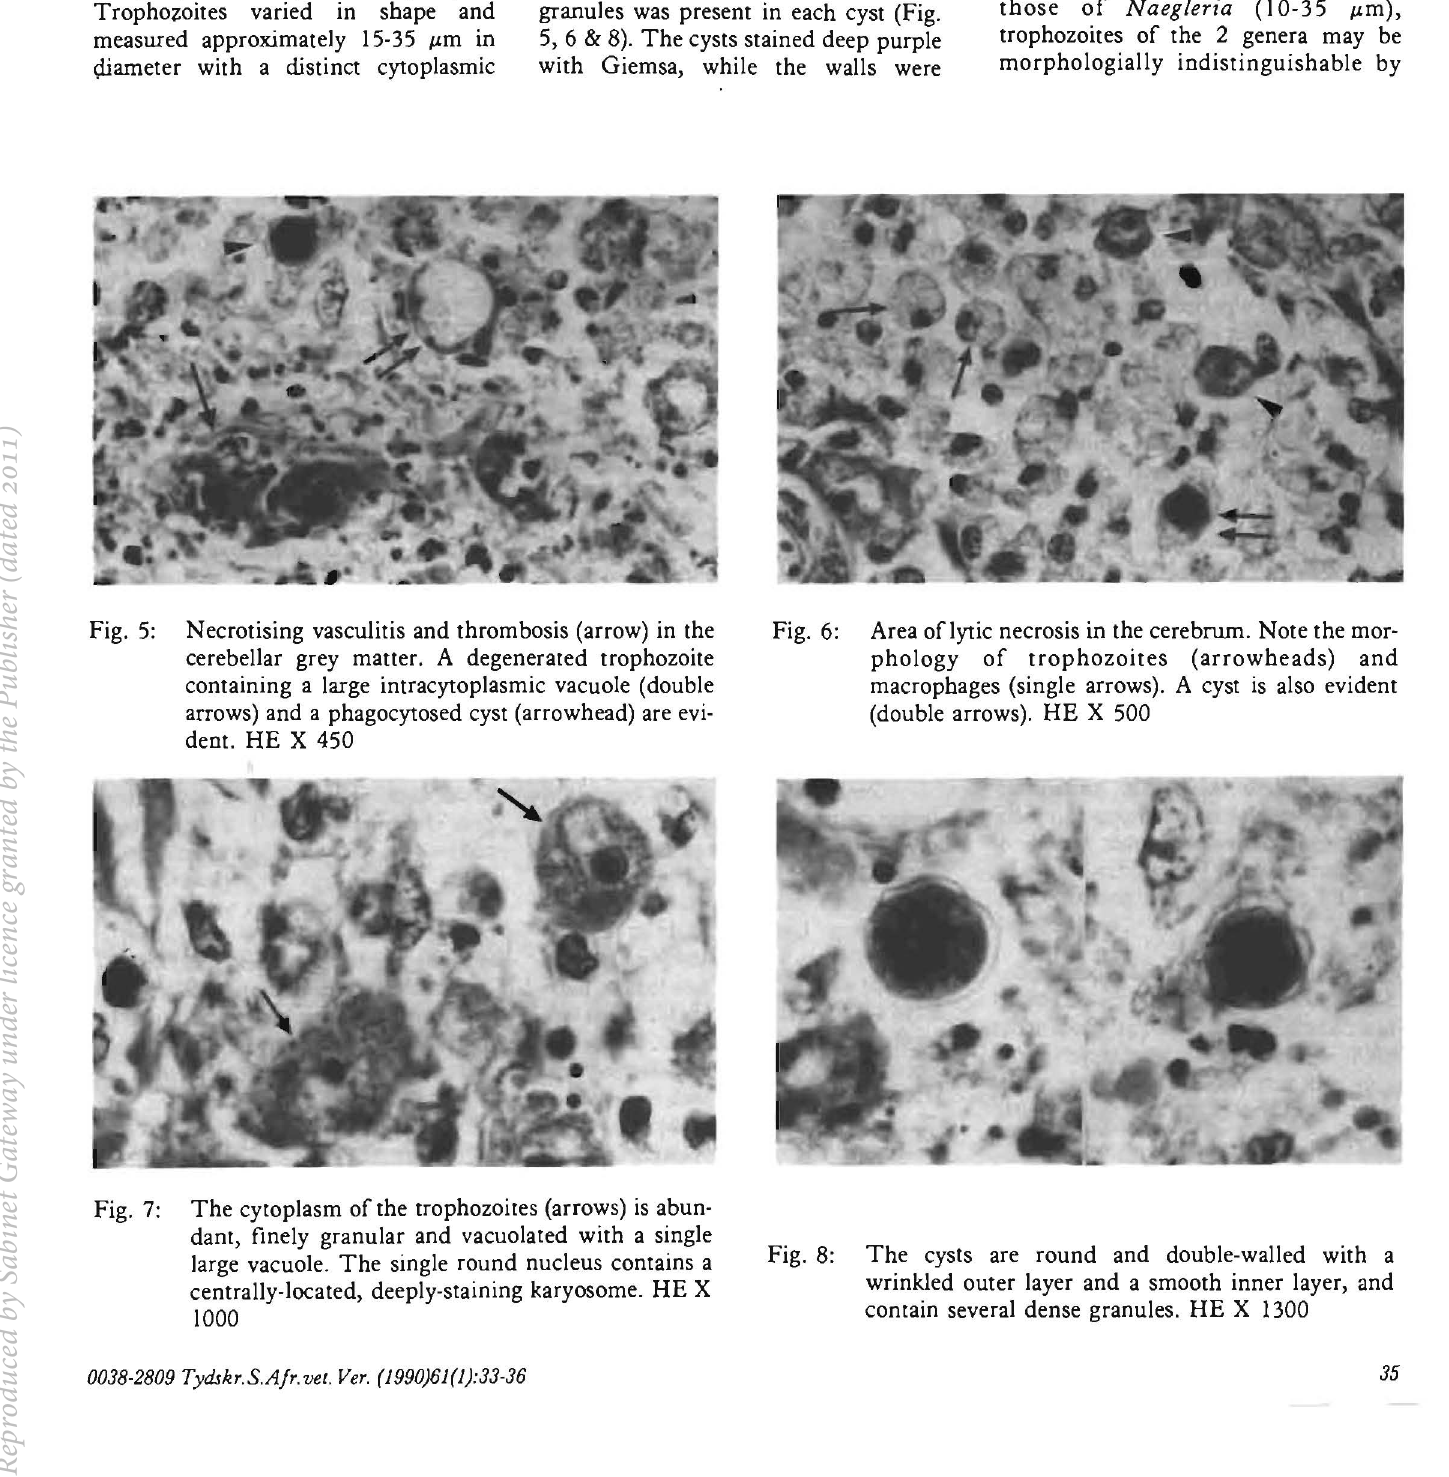
The cytoplasm of the trophozoites (arrows) is abun dant, finely granular and vacuolated with a single large vacuole. The single round nucleus contains a centrally-located, deeply-staining karyosome. HE X